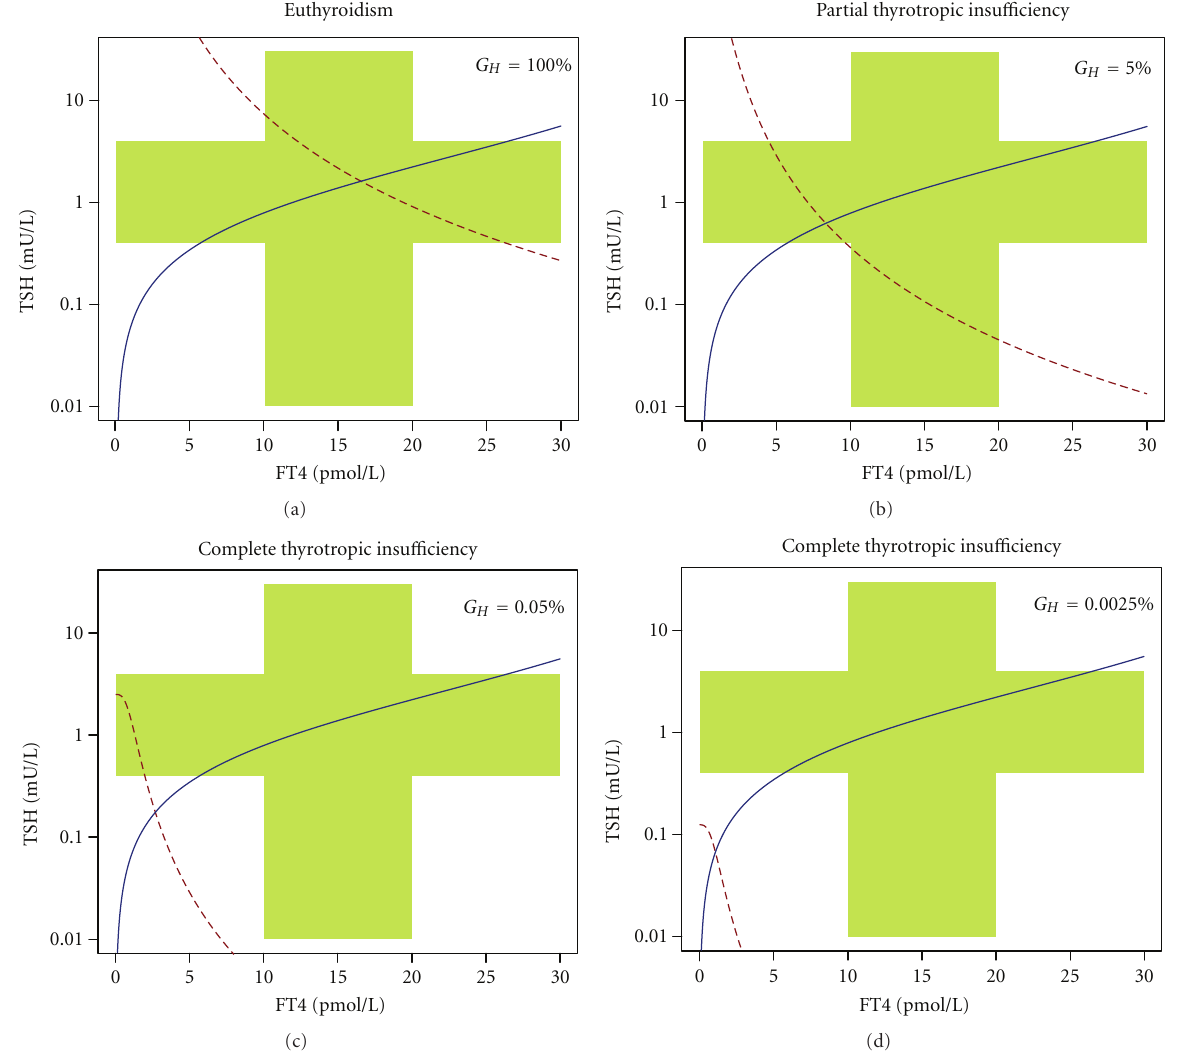
Figure 6: Partial and complete thyrotropic insu ffi ciency as results of nonlinear interaction of pituitary and thyroid. TSH axis is logarithmically scaled in order to zoom small values. G H values are given in percent from normal values. See text for additional